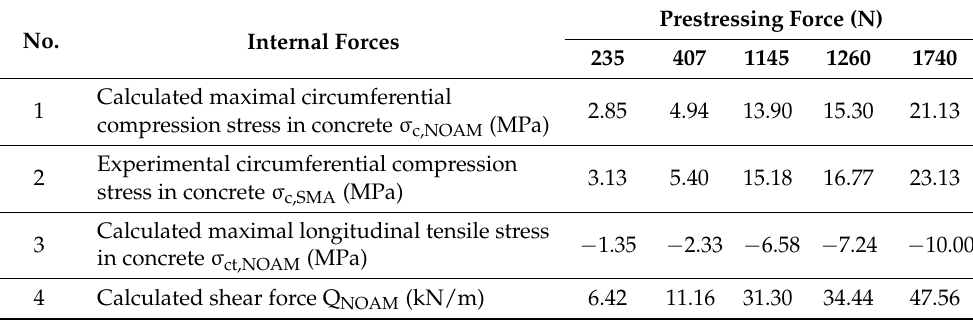
Table 3. Calculated and measured circumferential and longitudinal maximum concrete stress values and maximum cross-section force values in hollow cylinders with external diameter of 300 mm prestressed with Ni-Ti